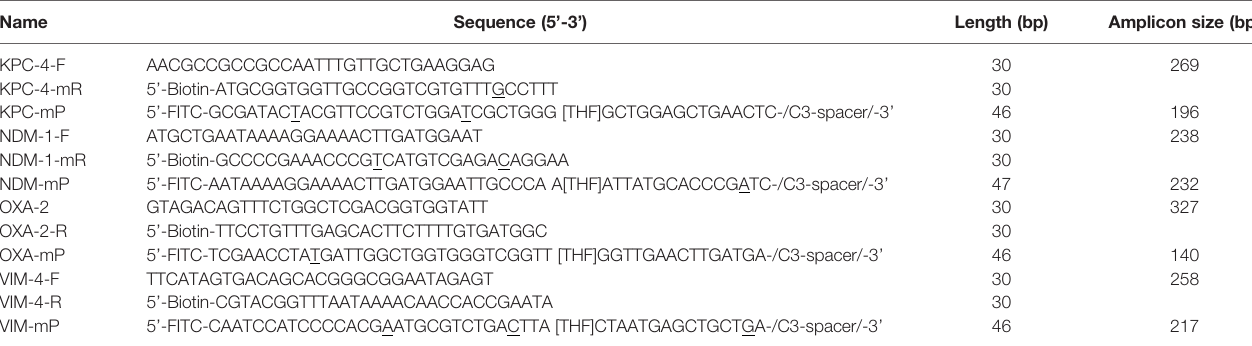
TABLE 2 | Primer-probe sets after base